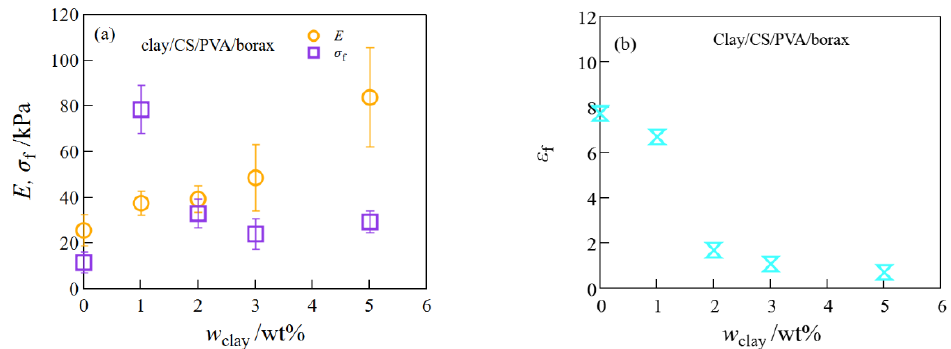
Figure 3. The Young’s modulus and the fracture stress ( a ) and the fracture strain ( b ) of the clay/CS/PVA hydrogels at different clay concentrations.